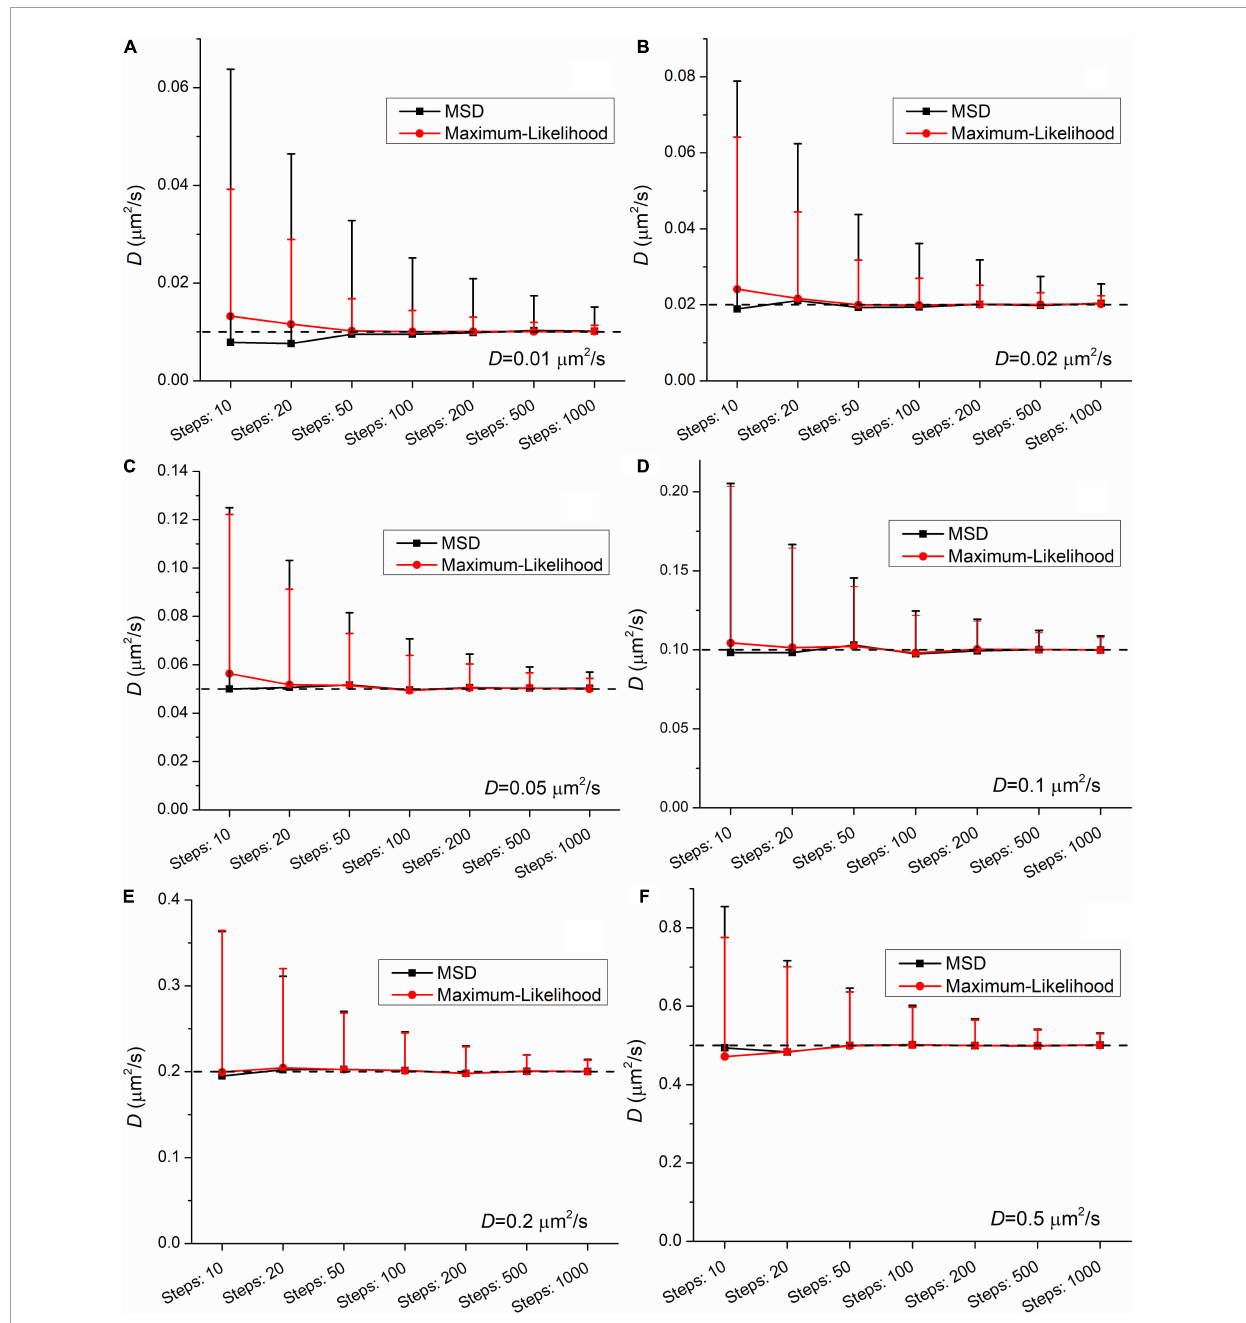
FIGURE2 Mean and standard deviation (SD) values of diffusion coefficients extracted from a set of trajectories ( N = 1,000) simulated with the following diffusion coefficients: (A) 0 . 01 µ m 2 / s , (B) 0 . 02 µ m 2 / s , (C) 0 . 05 µ m 2 / s , (D) 0 . 1 µ m 2 / s , (E) 0 . 2 µ m 2 / s , (F) 0 . 5 µ m 2 / s as a function of the length of trajectories. The diffusion coefficients were extracted by both the mean square displacement (MSD) (black) and maximum likelihood-based estimation (MLE) (red) method.